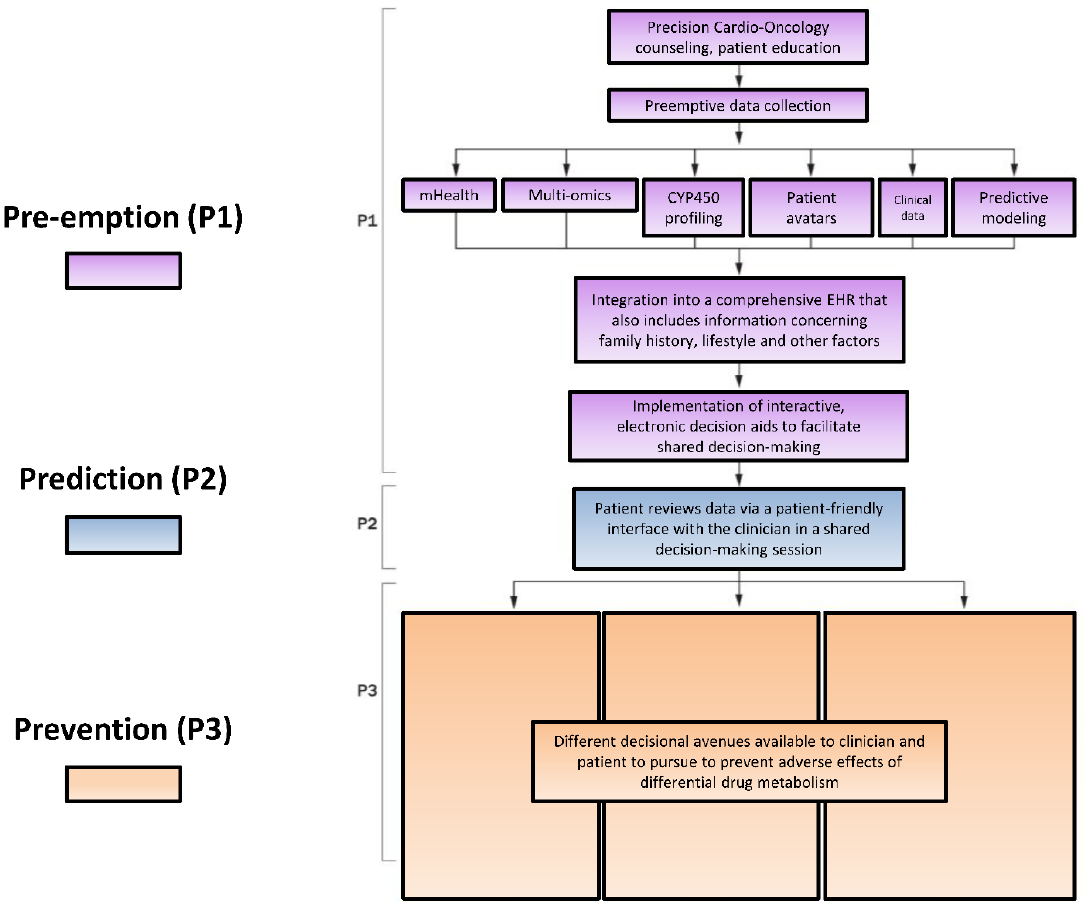
Figure 3. The P*3 Precision Medicine approach to individualizing therapy involving P450 enzymes. P1, Pre-empt: Pre-emption encompasses incorporation of elements of systems-based medicine, such as patients’ at-risk genetic polymorphisms, into the EHR seamlessly alongside clinical data. P2, Predict: Prediction describes the process of utilizing systems medicine data to estimate patients’ risk of developing cardiotoxicity. P3, Prevent: Prevention is proactively adjusting patients’ treatment plans based on their cardiovascular toxicity risk to prevent de novo damage or mitigate further damage from antineoplastic therapy. Adapted with permission [78]. CYP450 = cytochrome P450; EHR = electronic health record.